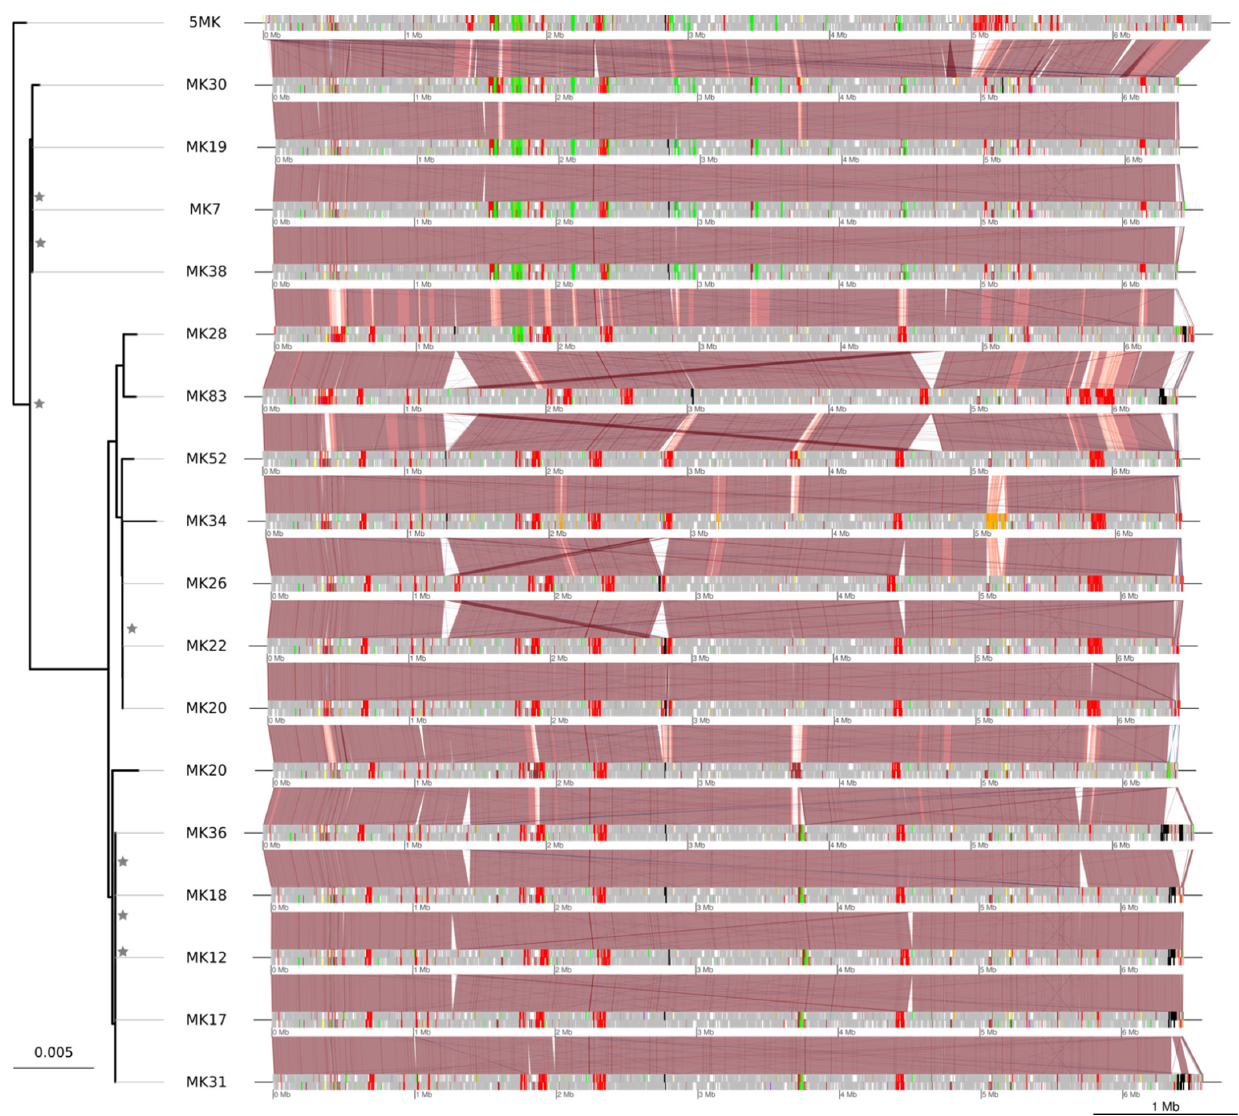
Figure 4. Distributive conjugal transfers within the species M. kansasii. For visual purposes, a subset of M. kansasii isolates was selected to illustrate the distributive conjugal transfers between members of the complex and the species M. kansasii . The remaining M. kansasii isolates are shown in Figure S4. The red stripes between genomes indicate aligned regions (BLASTN; e -value < 0.00001, nucleotide identity >87%), with a color gradient indicating the identity from 87% (light red) to 100% (dark red). Recombining loci are highlighted in bright red when the recombination occurred with M. persicum , in green with M. pseudokansasii , in orange with M. ostraviense , in yellow with M. innocens , in brown with M. attenuatum and in purple with M. gastri . Predicted prophages are highlighted in black. Some large DCTs between M. persicum or M. pseudokansasii and M. kansasii likely occurred in ancestral strains since they can be observed in the whole subset of strains (absent in Figure S4). Conversely, other large DCT, such as that between M. innocens and M. kansasii MK34, are likely more recent. Although all genomes displayed in this figure are draft genomes, they exhibit a high collinearity after contig reorder- ing. The maximum-likelihood phylogeny of the strains is an extracted subset of the core-genome phylogeny shown in Figure 1B.